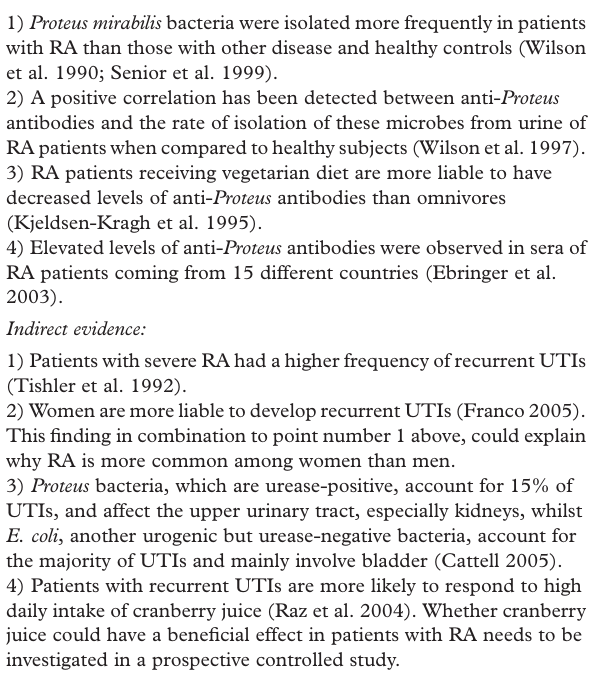
Table II. Direct and indirect evidence of the links between Proteus UTIs and RA Direct